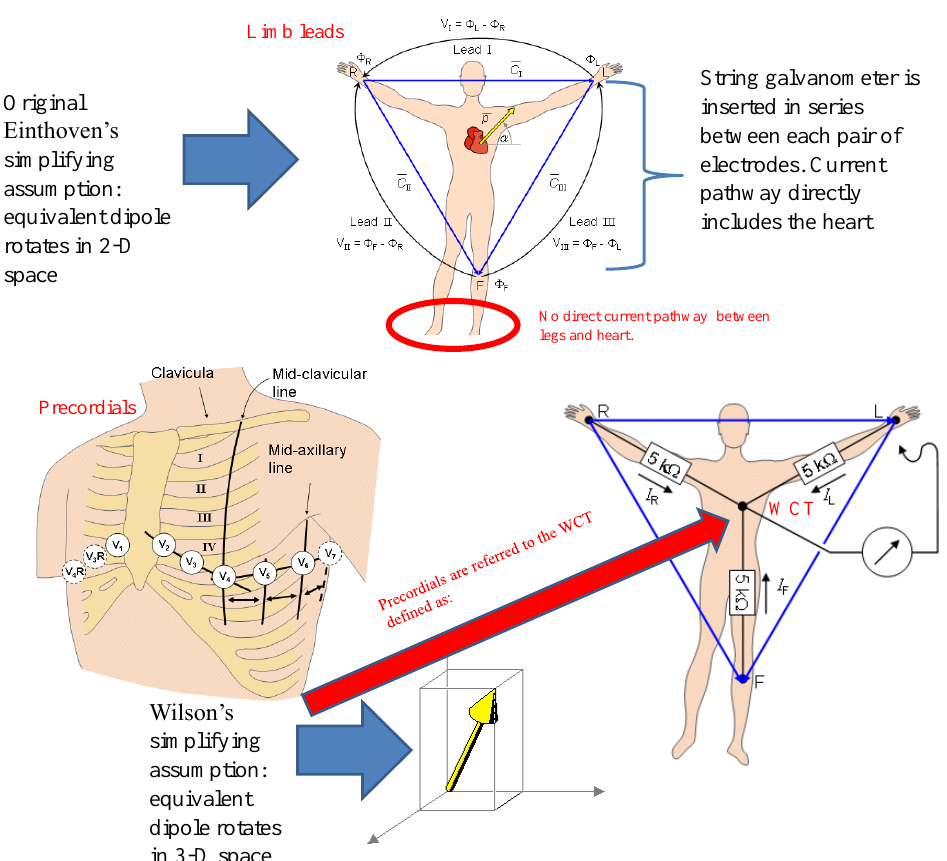
Figure 1. ECG conduction model evolution: Original Einthoven model (top), which included only the three limbs that form a triangular circuit around the heart, whereas the heart is included in each branch current pathway; Wilson’s precordial leads (bottom) with WCT definition as current return formed as the center of Einthoven’s triangle (bottom right). Modified from [1].